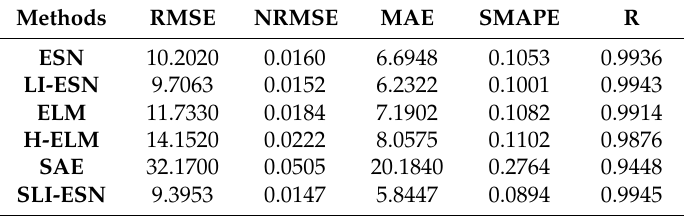
Table 2. Comparison of one-step (1 hour) prediction results. Abbreviations: root mean square error (RMSE), normalized root mean square error (NRMSE), mean absolute error (MAE), symmetric mean